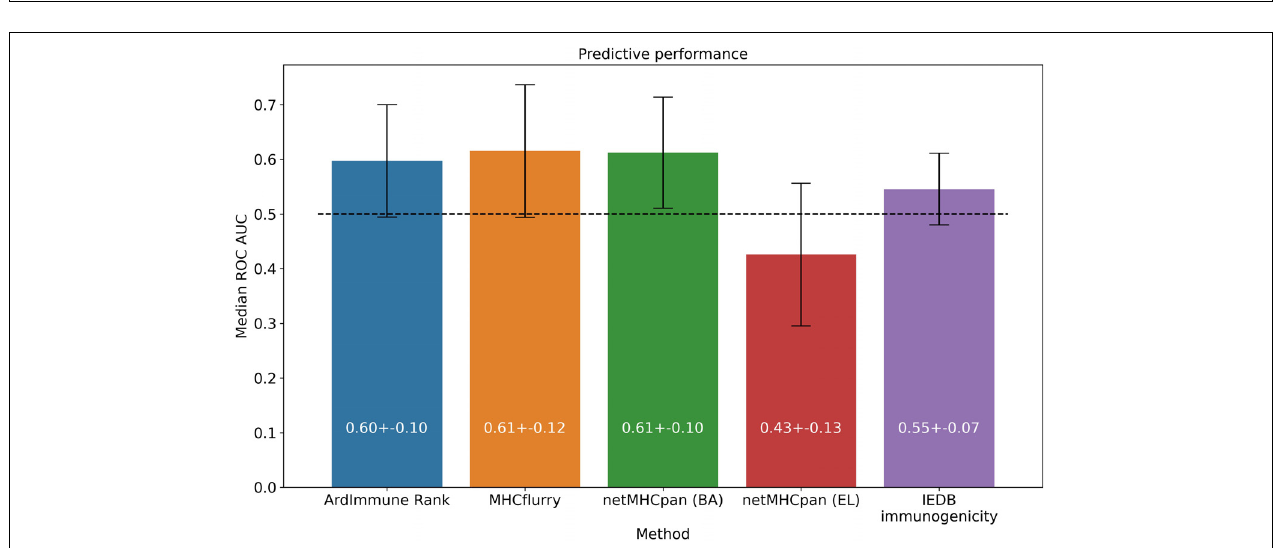
FIGURE 5 | Predictive performance of the selected models obtained in a LOGO cross validation and measured with ROC AUC. ArdImmune Rank, blue bars; MHCFlurry, orange bars; NetMHCpan (BA), green bars; NetMHCpan (EL), red bars; IEDB immunogenicity, purple bars.